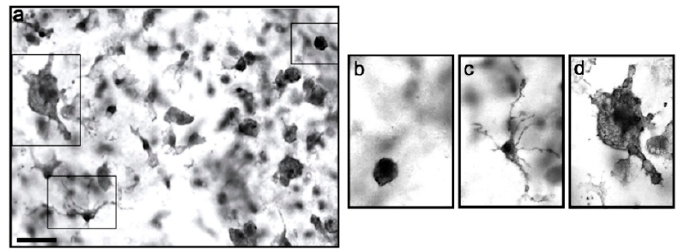
Figure 2. Microglia in the HC of OCs. Microglial cells were identified by selective labeling with anti-Iba1 and show a mixed population in terms of morphology ( a ). Microglia were mainly round-shaped ( b ) or highly ramified ( c ) though a few macrophage-like cells were also evident ( d ). Scale bar = 120 µ m ( a ) and 60 μ m ( b – d ).